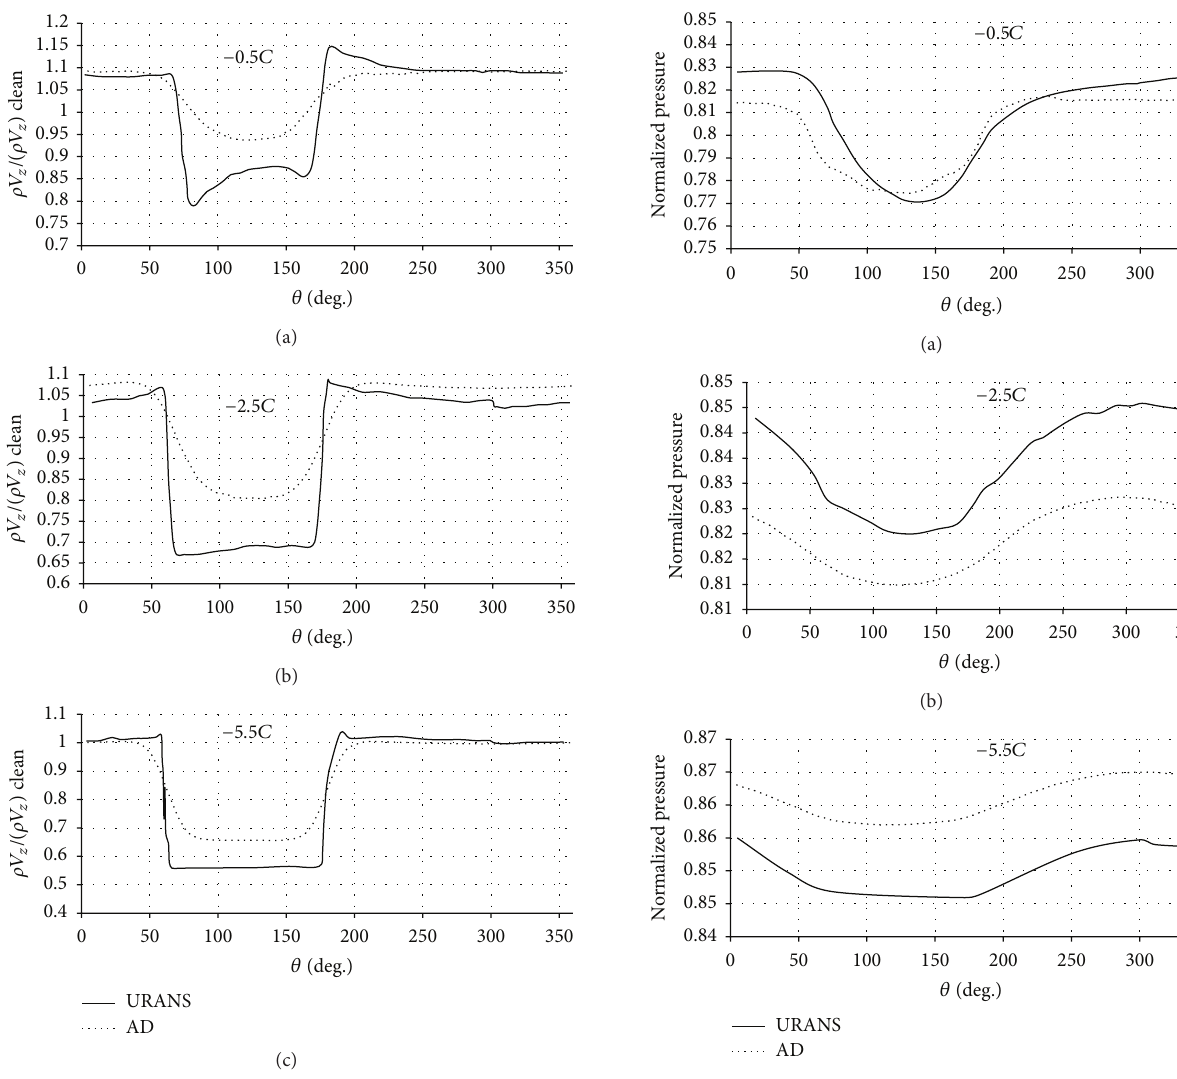
Figure 9: Comparison of unit mass flow rate for 3 reference planes.